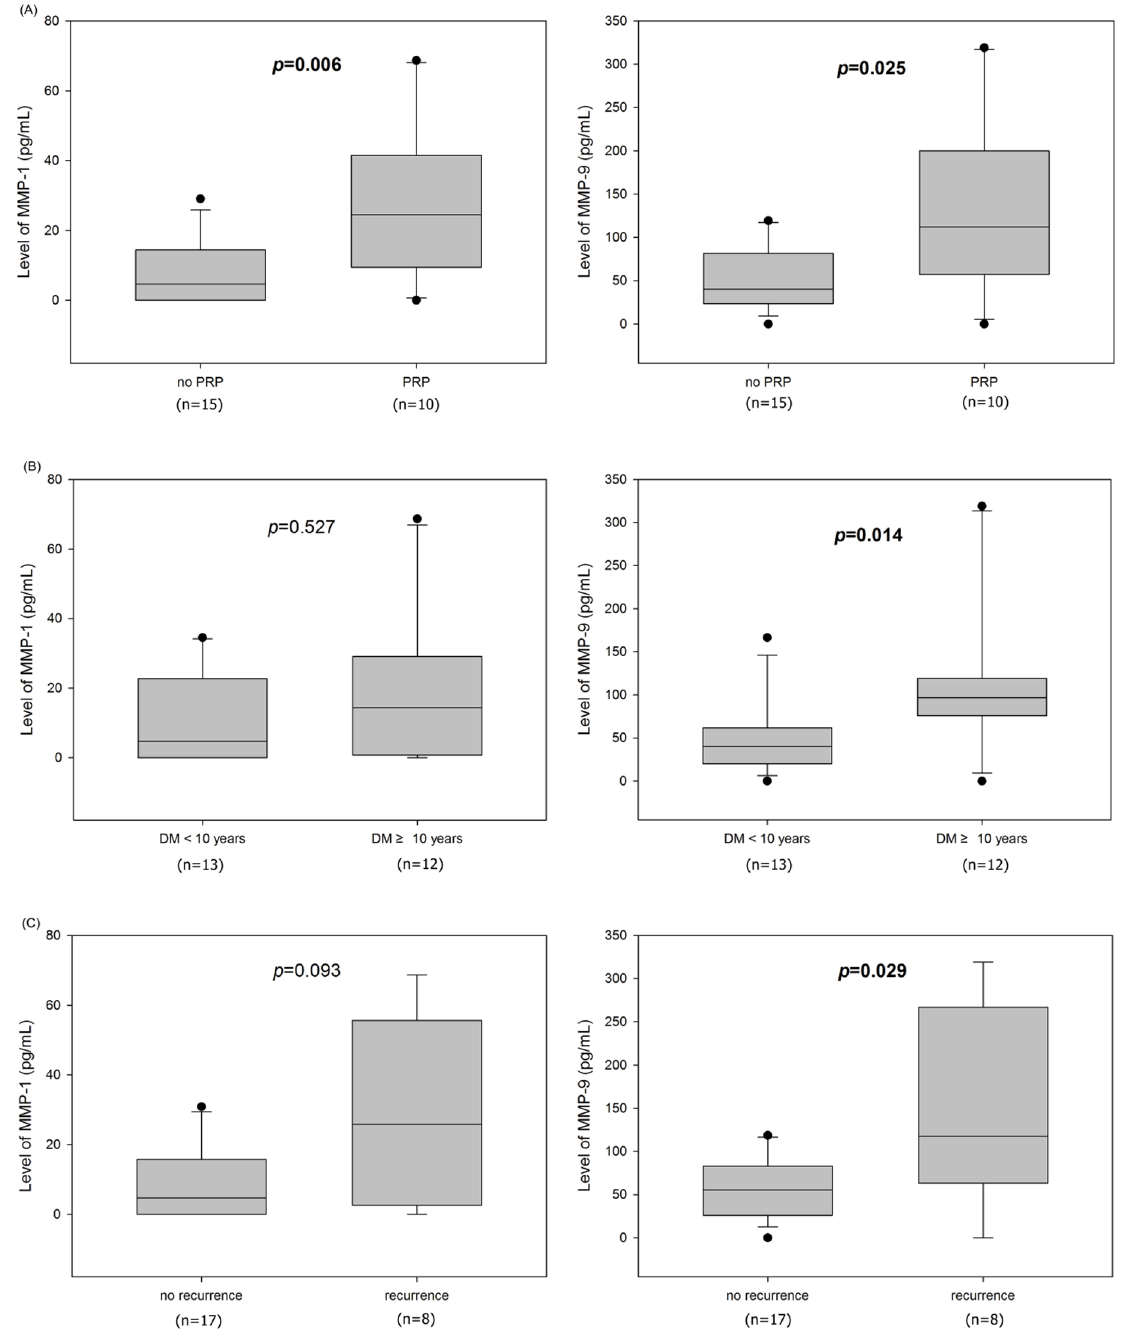
Fig 3. (A) Both metalloproteinase (MMP)-1 and MMP-9 concentrations were significantly higher in pan-retinal photocoagulation (PRP)-treated eyes. (B) MMP-9 concentration was significantly higher in DM eyes with diabetes (cid:1) 10 years. But there was no significant difference in level of MMP-1 between the two groups. (C) The eyes showed recurrence within 3 months of diabetic macular edema had significantly higher MMP-9 levels than non-recurrent eyes. But there was no statistical difference between the two groups in expression of